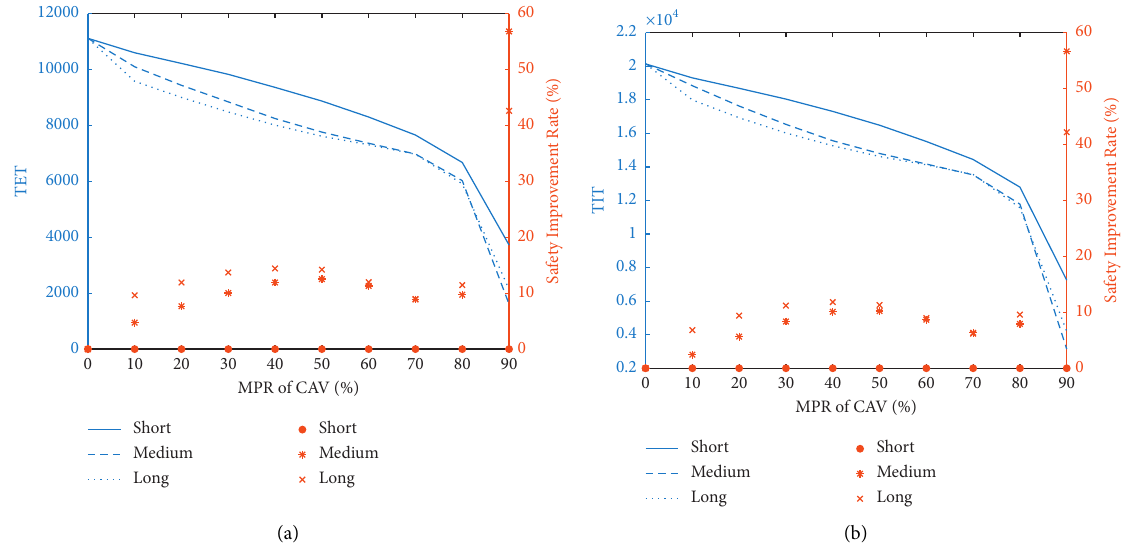
Figure 7: Results of three control execution sites. (a) TET. (b) TIT. Table 2: Safety improvement rates (medium vs.